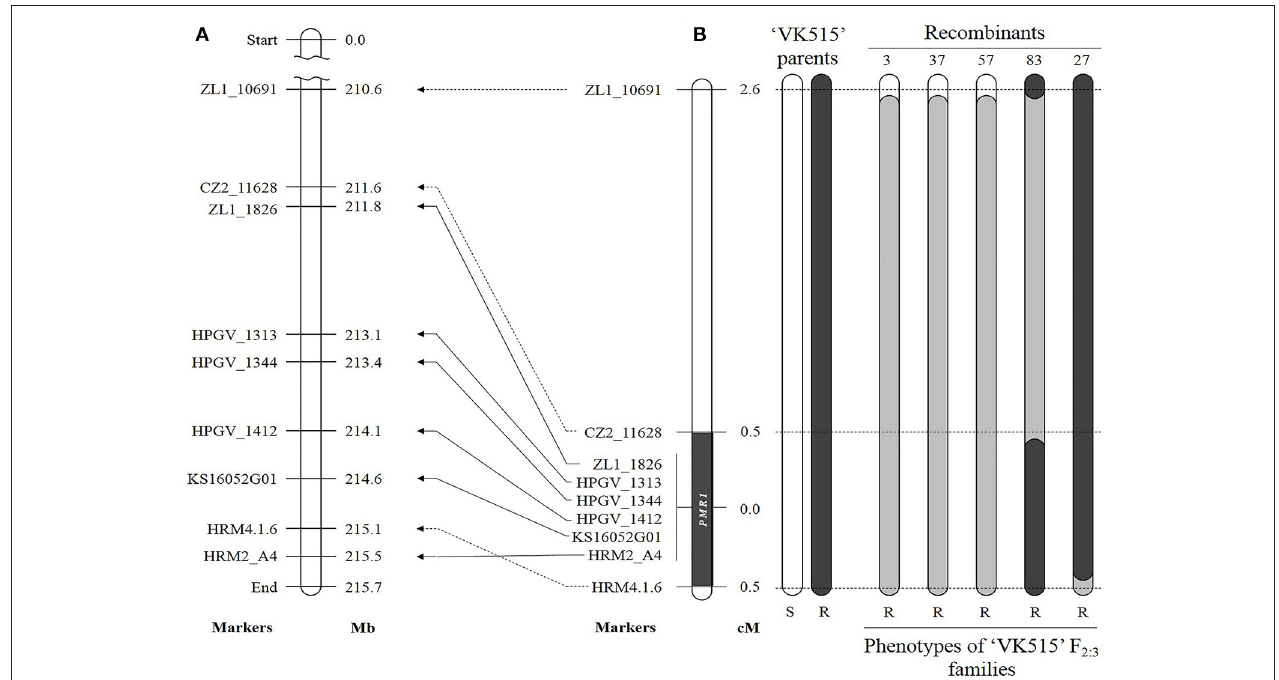
FIGURE 3 | Comparative genetic linkage and physical maps of the powdery mildew resistance gene PMR1. (A) Physical locations of linked markers on ‘L_Zunla-1’ chromosome 4. (B) Genetic map of ‘VK515’ F 2 : 3 families. Recombinant heterozygous resistant plants 3, 37, and 57; homozygous resistant plants 27 and 83. Eight SNP markers linked to the PMR1 locus are indicated next to pepper chromosome 4. Numbers on the right indicate genetic distances (cM). Black and white rectangles indicate the homozygous intervals of ‘VK515R’ and ‘VK515S’ chromosome 4, and gray rectangles indicate heterozygous intervals. The PMR1 locus was delimited to a 4 Mb-region between CZ2_11628 and HRM4.1.6 on ‘L_Zunla-1’ chromosome 4.